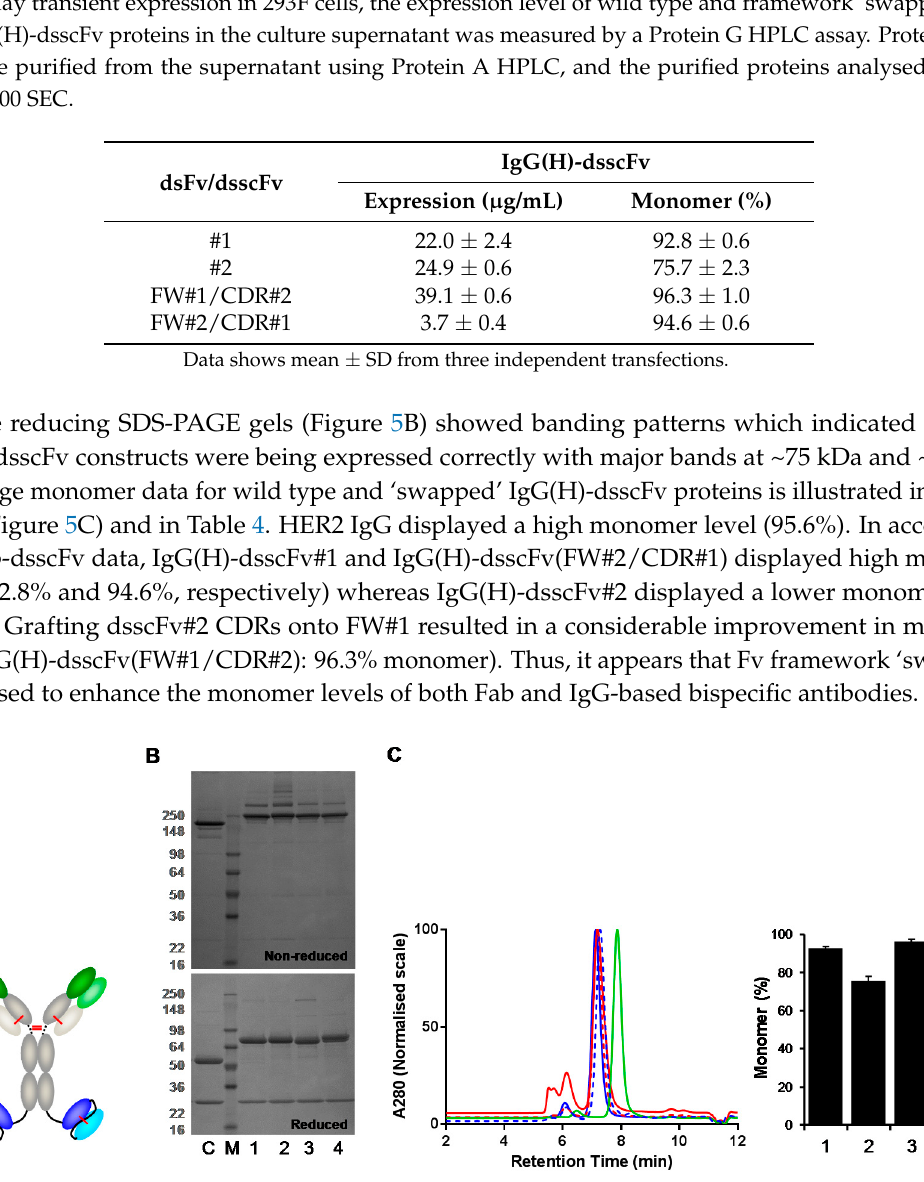
Figure 5. Comparison of IgG(H)-dsscFv with wildtype and FW/CDR-‘swapped’ Fv. SDS-PAGE and G3000 SEC analysis of proteins purified by Protein A HPLC from 293F cells – representative data from one of three independent experiments are shown. ( A ) Structure of IgG(H)-dsscFv. ( B ) Non-reducing and reducing SDS-PAGE gel of IgG(H)-dsscFv proteins. M—molecular weight marker; C—HER2 IgG